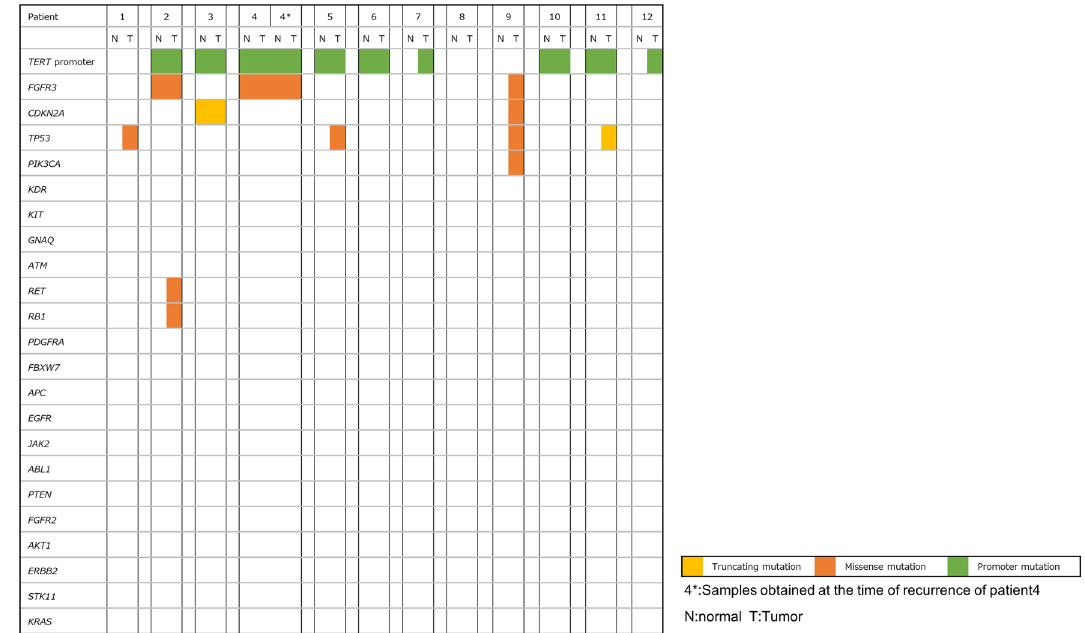
Figure 2. Paired analysis of normal urothelium and tumor. Somatic mutation status of normal urothelium (left), and tumor (right) were